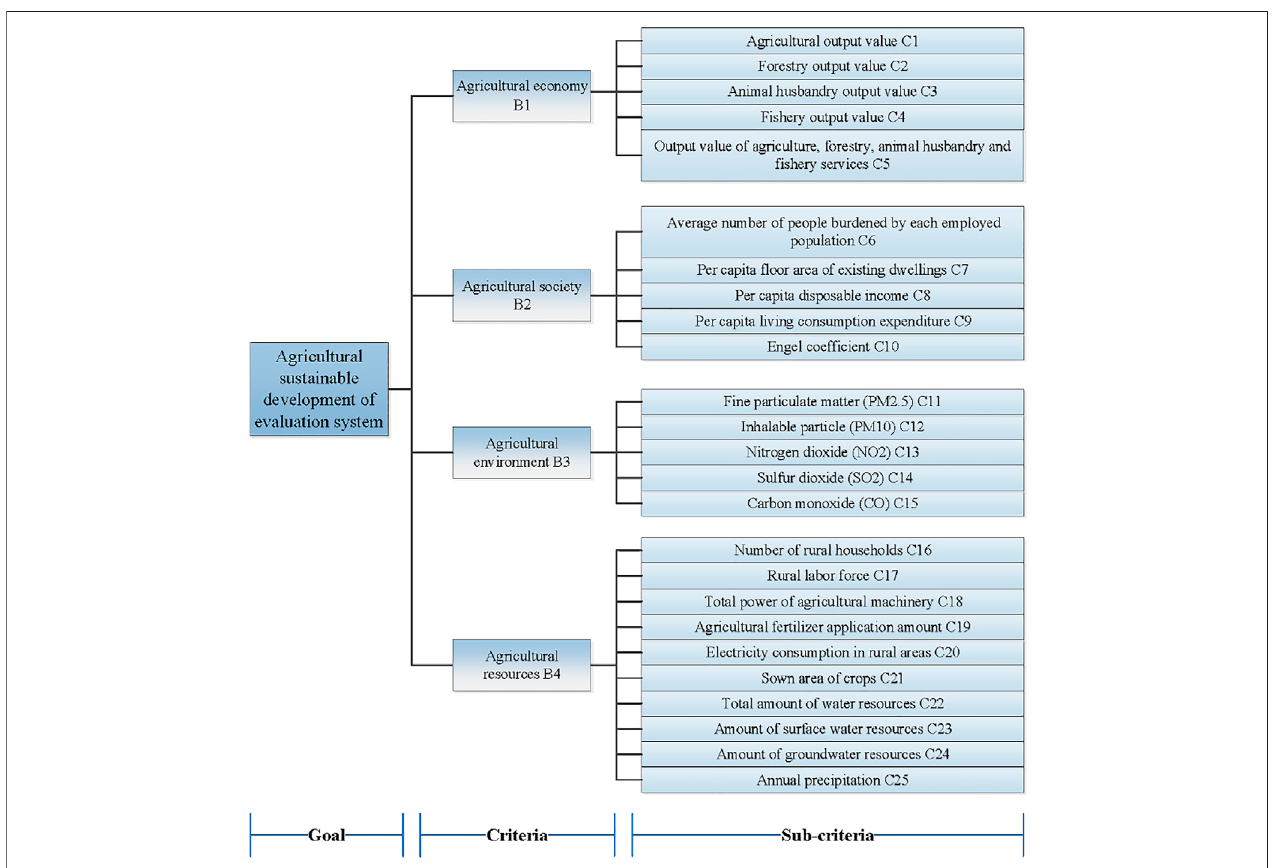
FIGURE 2 | Evaluation index system for sustainable agriculture in jiangsu